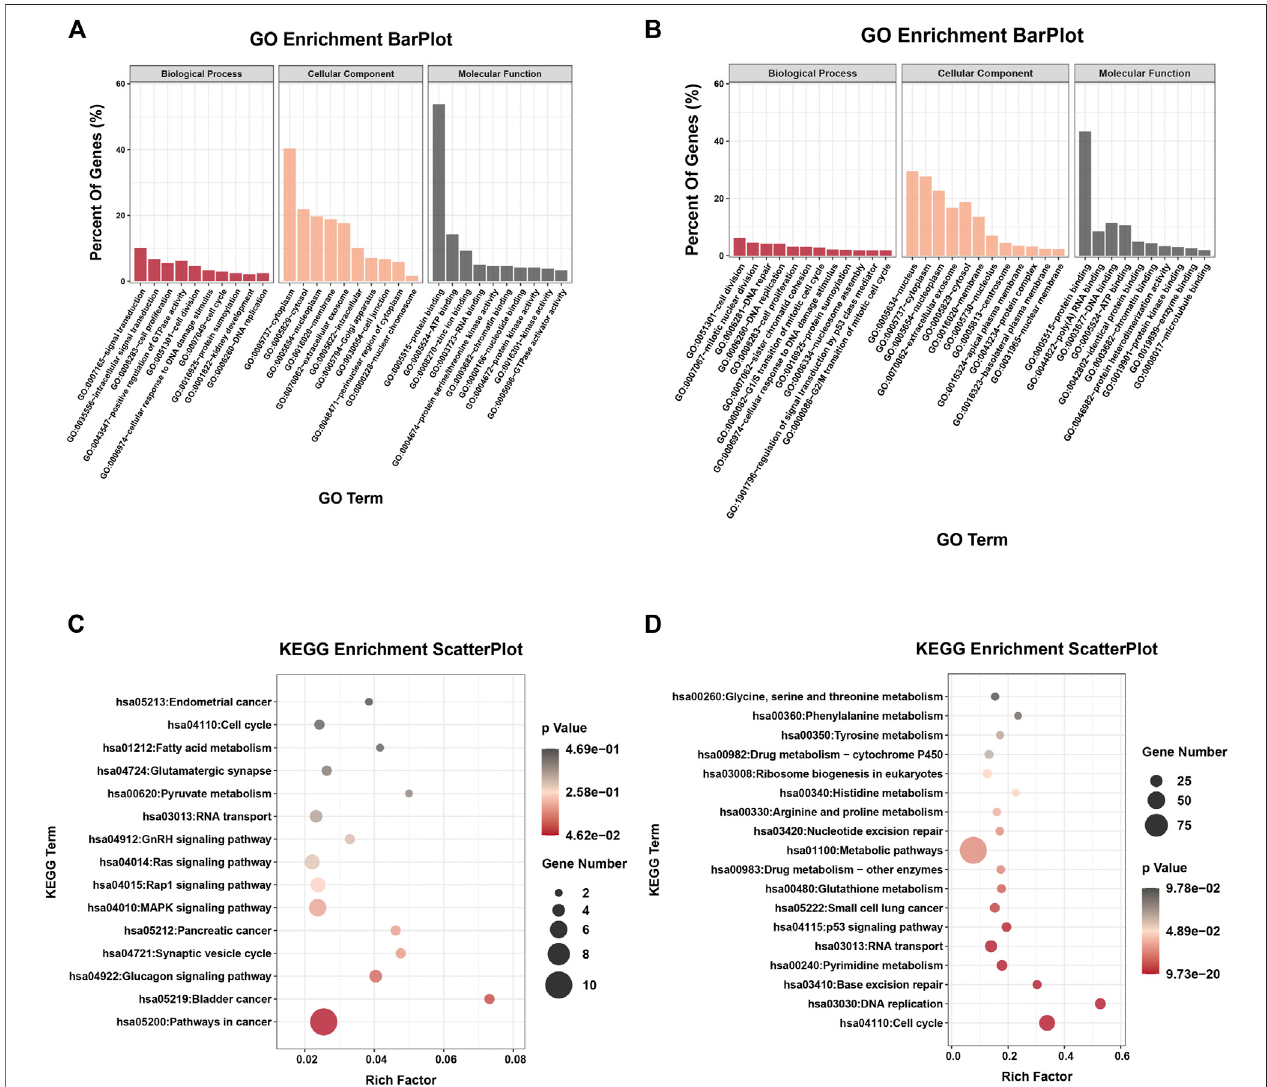
FIGURE 4 | GO and KEGG enrichment analysis of the parental genes of DE-circRs and DE-mRs. (A) GO enrichment analysis for the parental genes of DE-circRs. (B) GO enrichment analysis for DE-mRs. (C) KEGG enrichment analysis for the parental genes of DE-circRs. (D) KEGG enrichment analysis for DE-mRs. GO, Gene Ontology; KEGG, KyotoEncyclopedia of Genes and